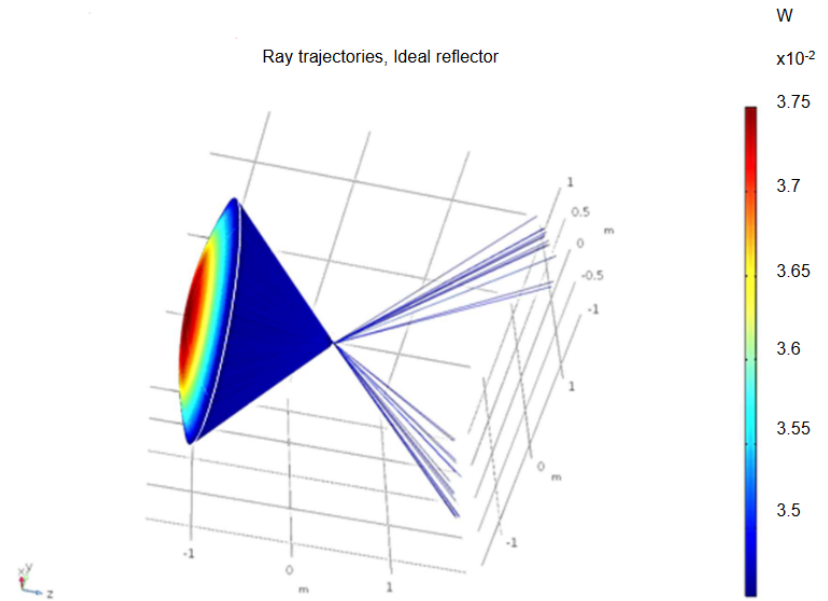
Figure 9. Trajectories of rays reflected by ideal reflector and focused onto receiver in terms of power density.